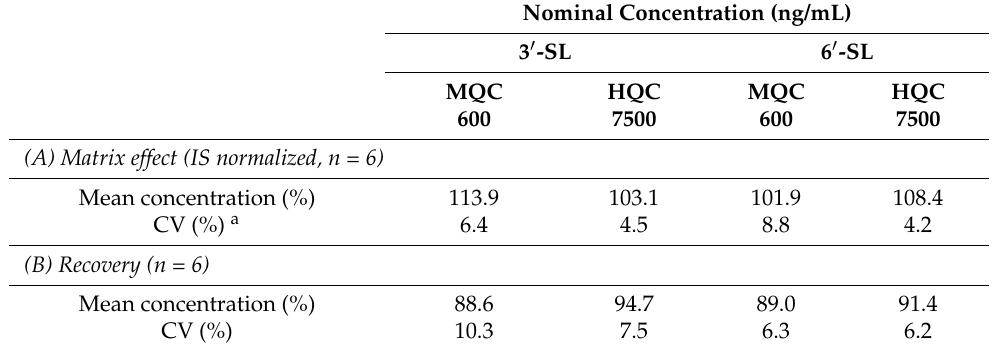
Table 3. Matrix effect and